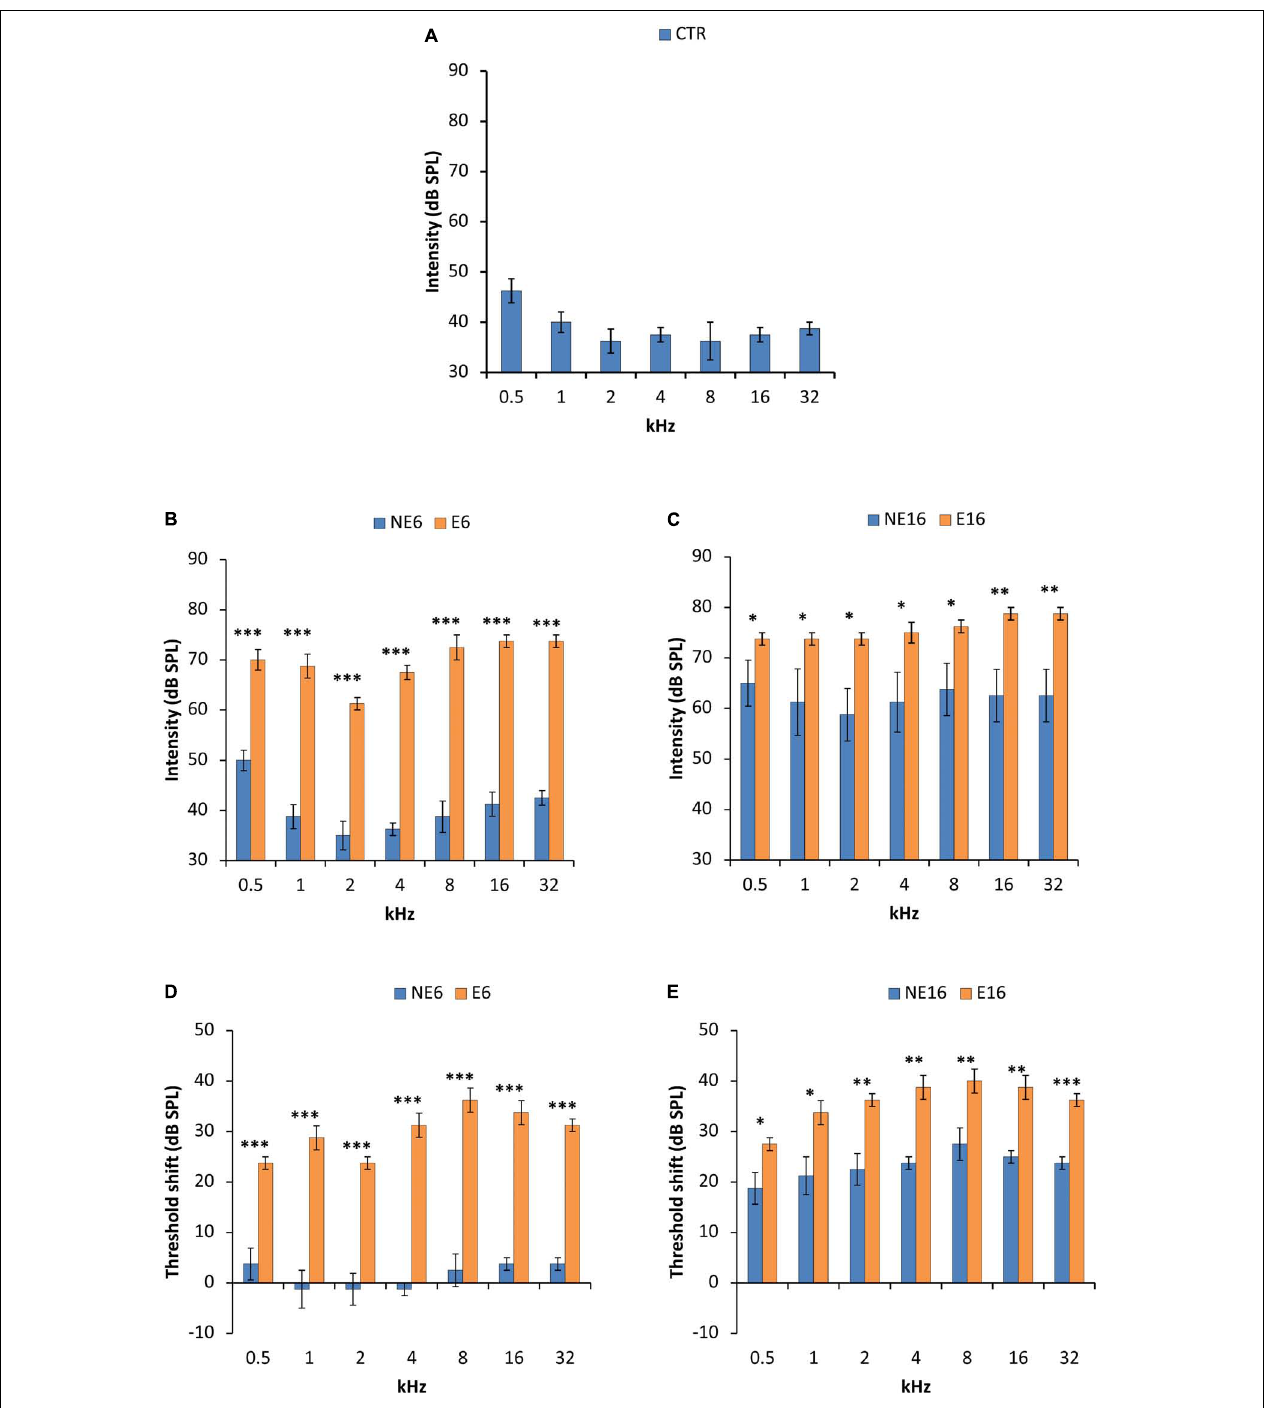
FIGURE 2 | Bar graphs illustrating auditory thresholds and threshold shifts in 3-month-old control rats (CTR) and in non-exposed (NE6 and NE16) and NAP-exposed (E6 and E16) rats for all frequencies assessed. The mean values found in CTR (A) and NE6 (blue bars in B ) rats were similar, with threshold shifts (blue bars in D ) between –1.3 and + 3.8 relative to CTR animals. However, as animals aged (NE16), the mean thresholds (blue bars in C ) and threshold shifts (blue bars in E ) were higher than in CTR and NE6 rats. Following NAP, mean threshold values (orange bars in B ) and threshold shifts (orange bars in D ) were elevated as early as 6 months of age and were significantly different from those in CTR and NE6 rats. The oldest noise-exposed rats presented even higher thresholds (orange bars in C ) and threshold shifts (orange bars in E ) relative to CTR and unexposed animals. ∗ p < 0.05; ∗∗ p < 0.01; ∗∗∗ p < 0.001. n = 4 for each animal group.